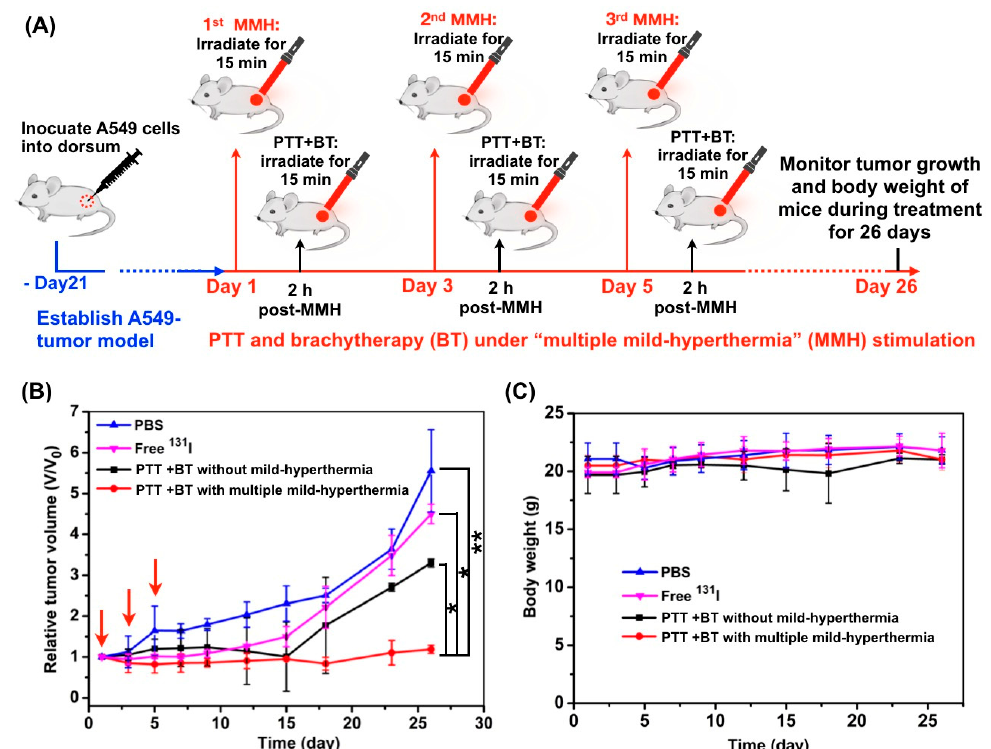
Figure 6. In vivo anti-tumor efficiency of photothermal brachytherapy. ( A ) Scheme of the combined photothermal brachytherapy under multiple mild-hyperthermia stimulation in A549 tumor-bearing mice. ( B ) Tumor growth curves after treatment with PBS, free 131 I, photothermal brachytherapy (PTT + BT) without mild hyperthermia, and photothermal brachytherapy (PTT + BT) with multiple mild-hyperthermia, respectively. Red arrows indicated the time points for mild-hyperthermia stimulation. ( C ) Changes of body weight of mice. * p < 0.05, ** p < 0.01.